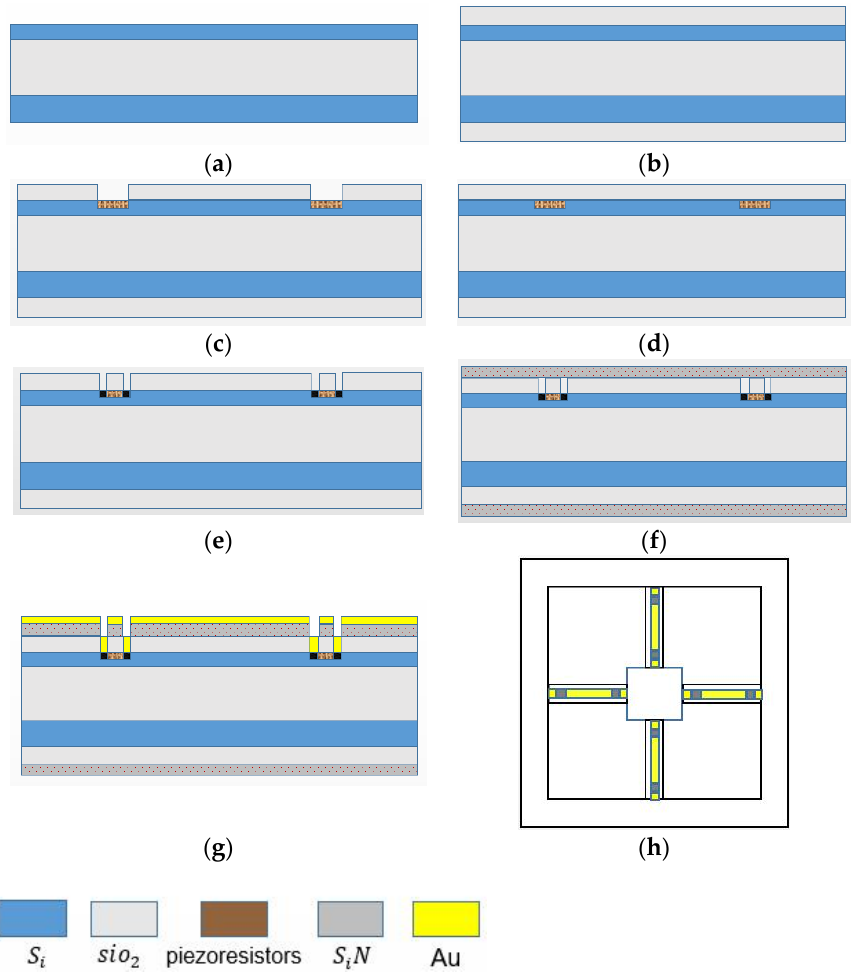
Figure 11. The processing technology of vector channel microstructure. ( a ) Preparation of SOI wafer; ( b ) oxidization to form silicon dioxide layer; ( c ) ICP etching and boron implantation; ( d ) re-oxidization; ( e ) ICP etching and heavily boron implantation; ( f ) silicon nitride depositing; ( g ) silicon nitride etching and Au deposition; ( h ) structure release.